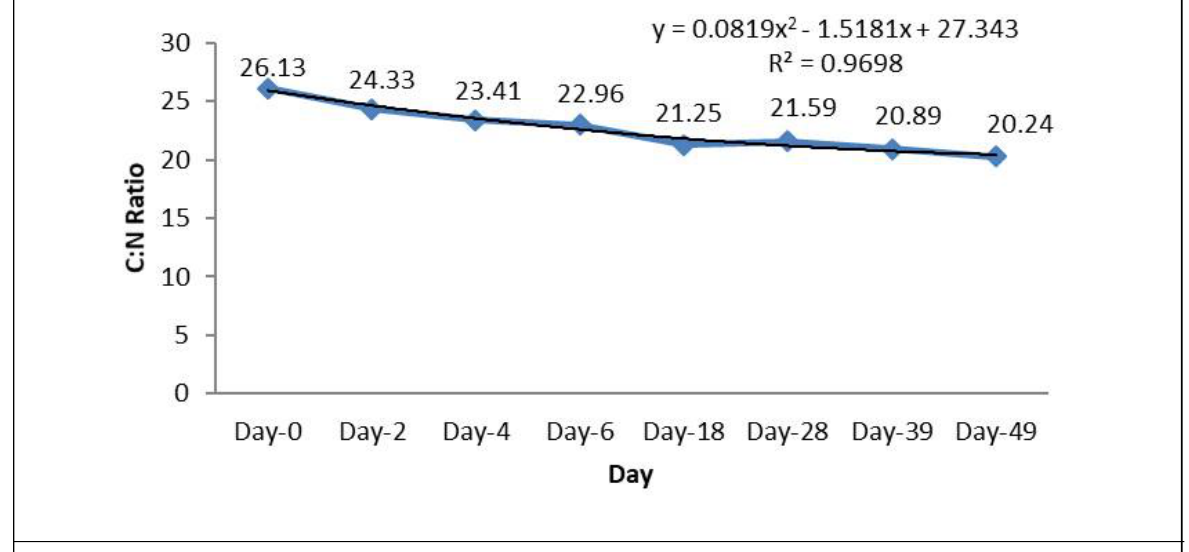
Figure 1: C:N ratio variation during WBM ( A. bisporus ) composting and